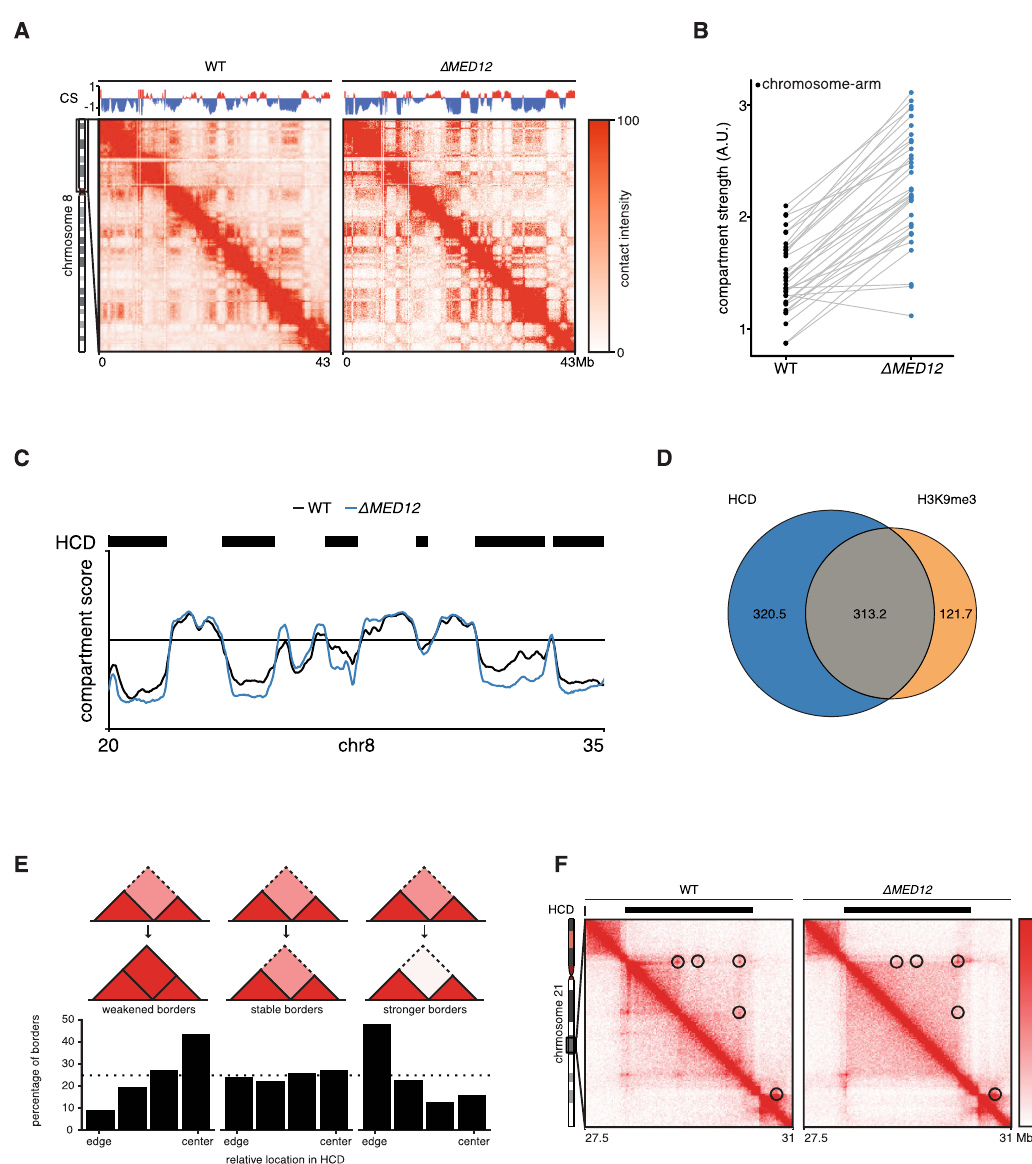
Fig. 3 Loss of MED12 affects 3D genome organization. A ICE normalized Hi-C contact matrices at 100 kb resolution for WT and Δ MED12 are shown for the p arm of chromosome 8. Above the matrices the compartment score is plotted. Contact matrices are visualized using GENOVA. B The compartment strength is calculated for all chromosome arms in WT and Δ MED12 cells. Lines connect scores for the same chromosome arm. C Compartment scores for a speci fi c region on chromosome 8 for WT (black) and mutant (blue) cells. Black rectangles show hypercompartmentalized domains (HCDs) identi fi ed by a custom hidden markov model. D Venn diagram shows the overlap in genome-wide coverage between HCDs identi fi ed in Δ MED12 and H3K9me3 domains identi fi ed in WT cells. E TAD borders in HCDs were strati fi ed into three categories depending on their difference in TAD separation ( “ weaker ” , “ unchanged ” , “ stronger ” ). The relative position within an HCD is plotted. F ICE normalized Hi-C contact matrix at 20 kb resolution for WT and Δ MED12 cells are shown for a region on chromosome 21. Contact matrices are visualized using GENOVA. Black rectangles indicate the position of